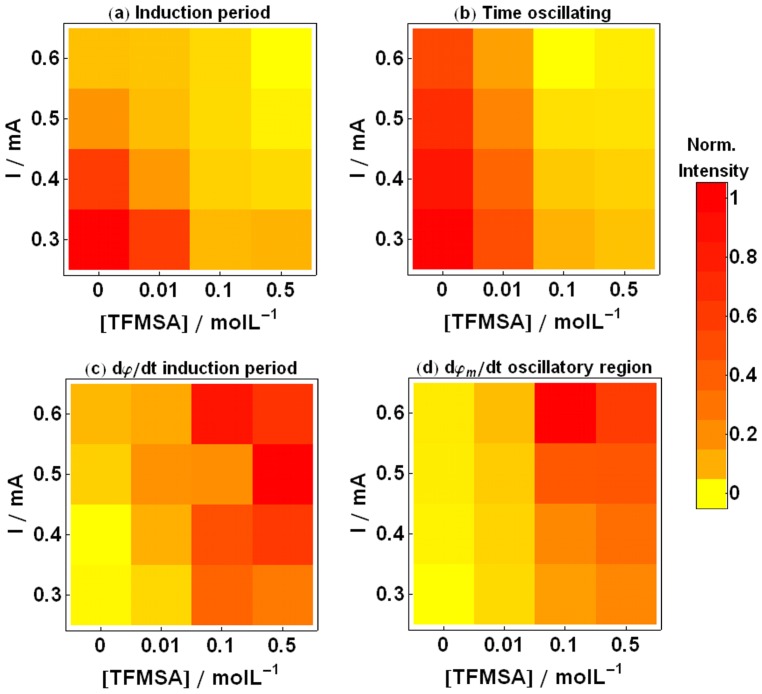
Oscillatory features as a function of the applied current and amount of anion.Maps obtained with data extracted from Erro! Fonte de referência não encontrada. relating the induction period, the time that the system spends in oscillatory region and the rate of change of potential during the induction period for several values of applied current and composition.